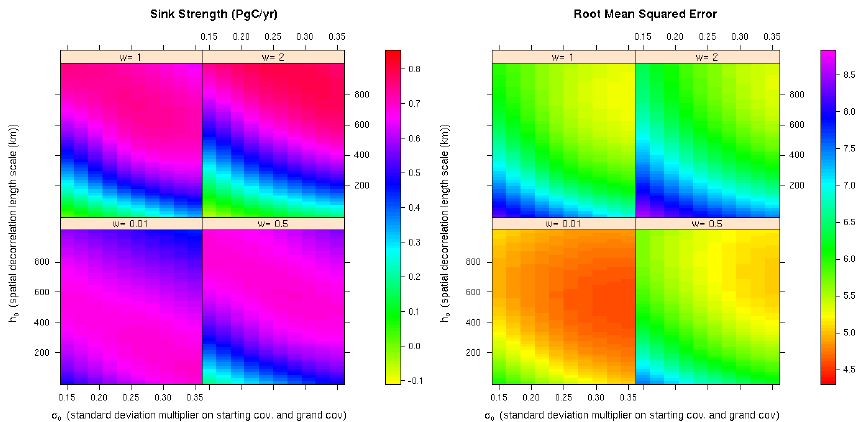
Figure 9: Sensitivity of (a) sink estimate and (b) root mean squared error to varying covariance parameters in inversion. For example, a set of parameter values like w =0, h 0 = 600 km, σ 0 = 0.35 provides the estimate w/ the lowest RMSE (panel b) and an estimated sink of approximately 0.55 PgC/yr (panel a). Nevertheless, qualitatively, this represents a maximum departure from the prior and thus must be viewed with some skepticism due to the likelihood of overfitting the data.